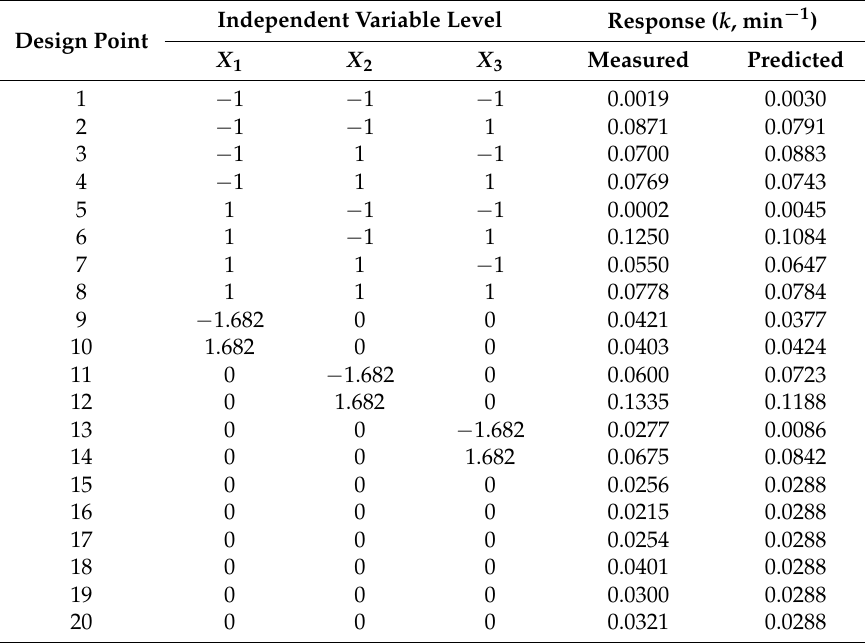
Table 2. Measured and predicted values of k at all design points used for the response surface